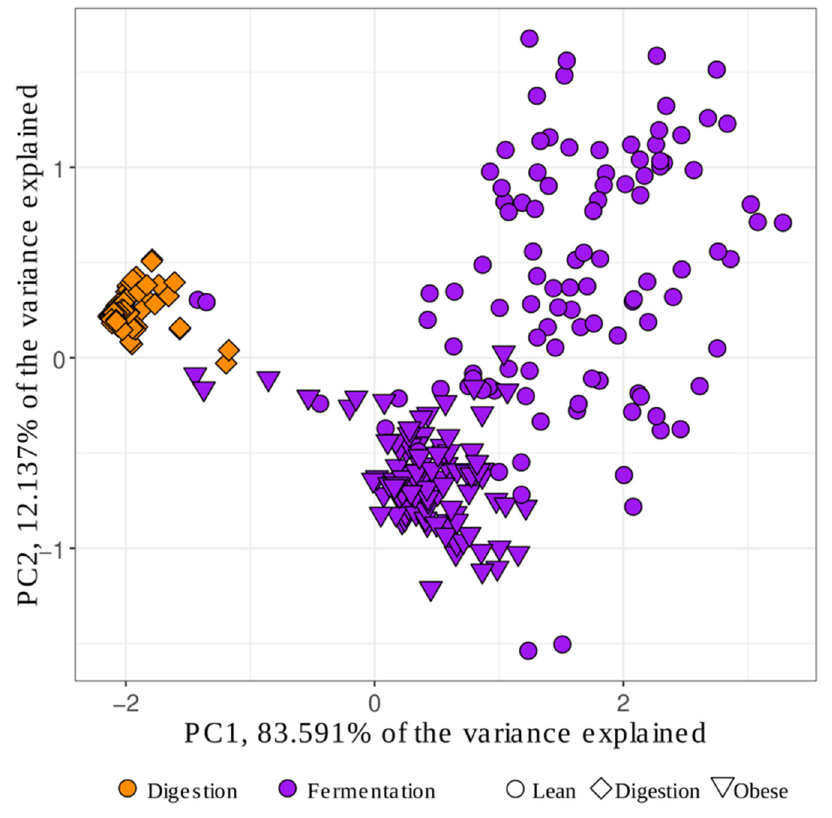
Figure 6. Principal Component Analysis of total antioxidant capacity obtained from different intervention groups with the three methods used (Folin–Ciocalteu, FRAP and DPPH).